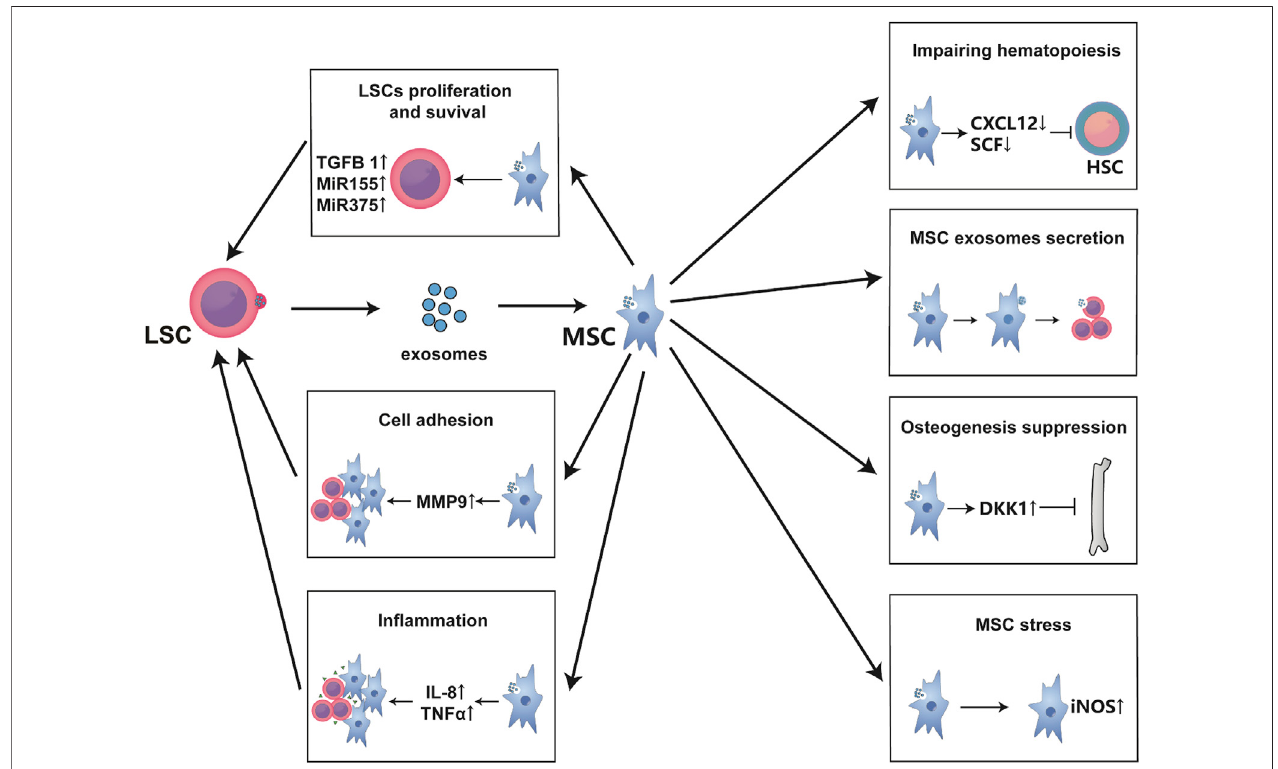
FIGURE 3 | Exosomes are the main communication means between MSCs and LSCs. Exosomes secreted from LSCs are mainly absorbed by MSCs and endothelial cells. These exosomes usually alter the hematopoietic support function of MSCs to form a leukemia-permissive microenvironment mainly through the secretion of mass cytokines and microRNAs. As shown in the fi gure, these mass cytokines often form an in fl ammatory environment, promote the proliferation and survival of LSCs, and increase their invasion and adhesion while inhibiting normal hematopoiesis. Besides, LSC-derived exosomes lead to MSC oxidative stress, affecting the exosomes secretion of MSCs and bone